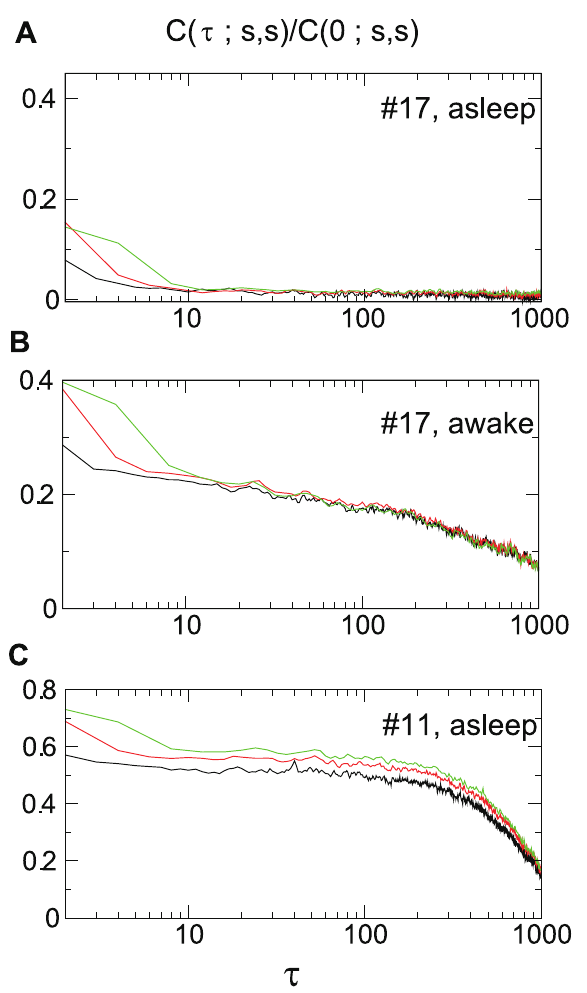
Figure 5. Magnitude correlation functions with s 1 ~ s 2 ~ s . Normalized magnitude correlation, C ( t ; s , s ) = C (0 ; s , s ) , calculated at s ~ 16 (black), s ~ 32 (red) and s ~ 64 (green) are plotted against non- dimensional distance, t . The correlation was calculated for neuron # 17 during sleep (A) and waking (B), and neuron # 11 during sleeping (C).